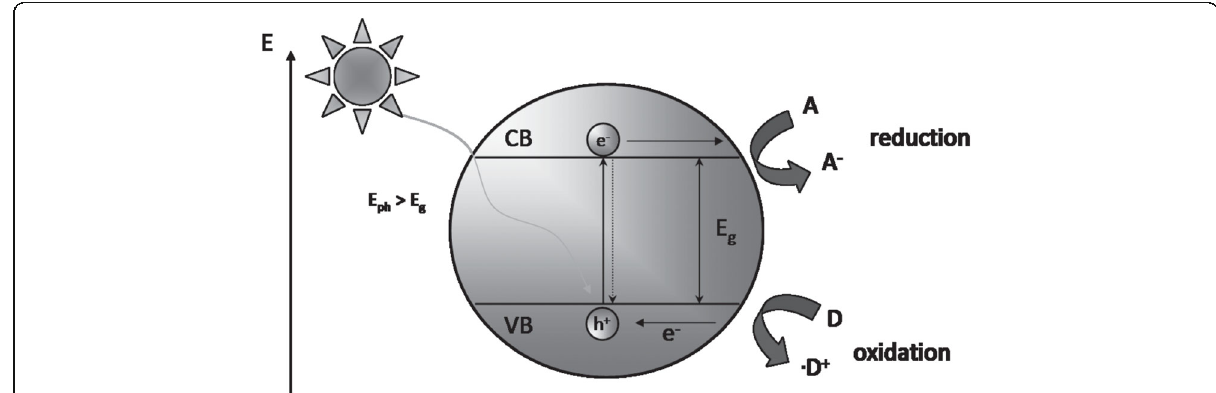
Fig. 6 A systematic depiction of the general mechanism of photocatalytic semiconductor. Reproduced with permission [29]. Copyright 2013 WILEY-VCH Verlag GmbH & Co. KGaA,